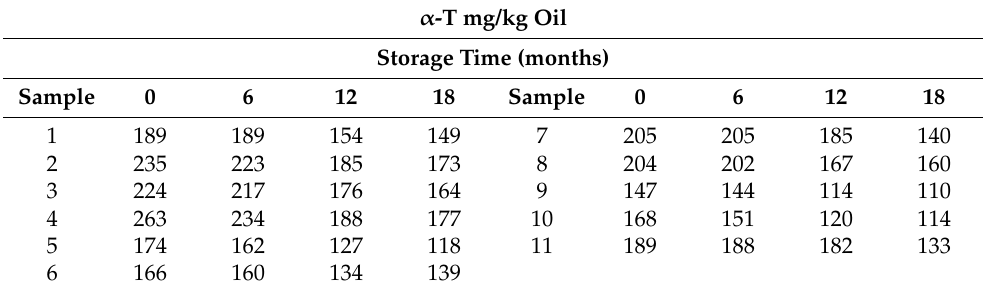
Table 2. α -Tocopherol ( α -T) content (mg/kg oil) of VOO samples cv. Chondrolia Chalkidikis and Chalkidiki from the main olive mills of the regional unit of Chalkidiki during the 18-month storage in the dark at room